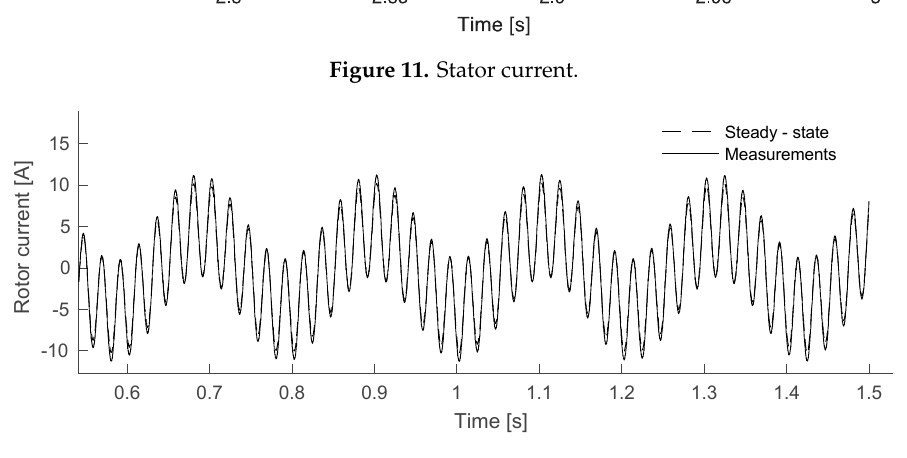
Figure 12. Rotor Figure 12. Rotor current. Figure 12. Rotor current.